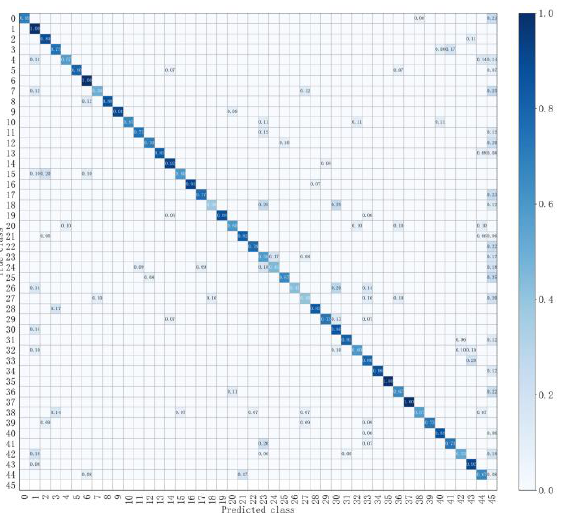
Figure 8. The confusion matrices of second and third step on RSI dataset.